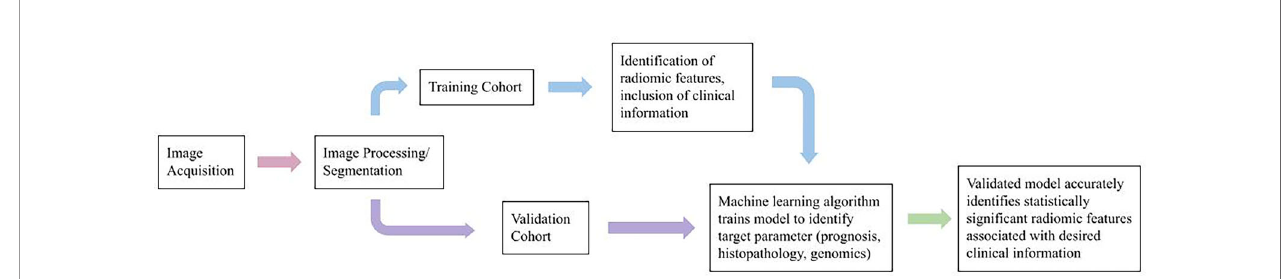
FIGURE 1 | Typical radiomic work fl